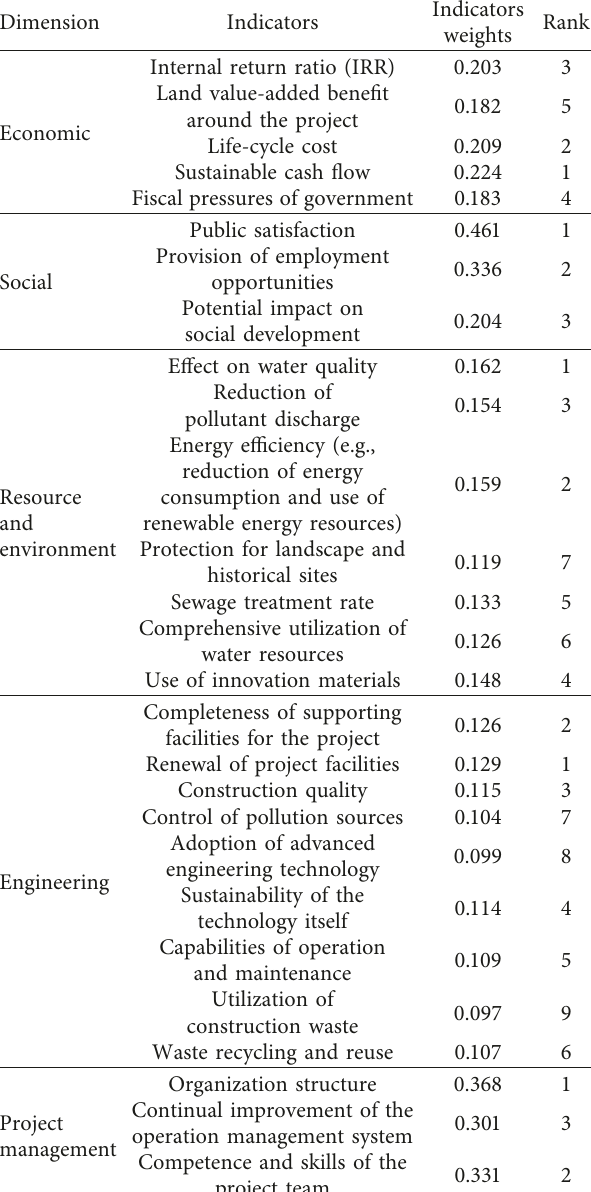
Table 7: The standardized regression weights and covariance es- timates of the modified measurement model.